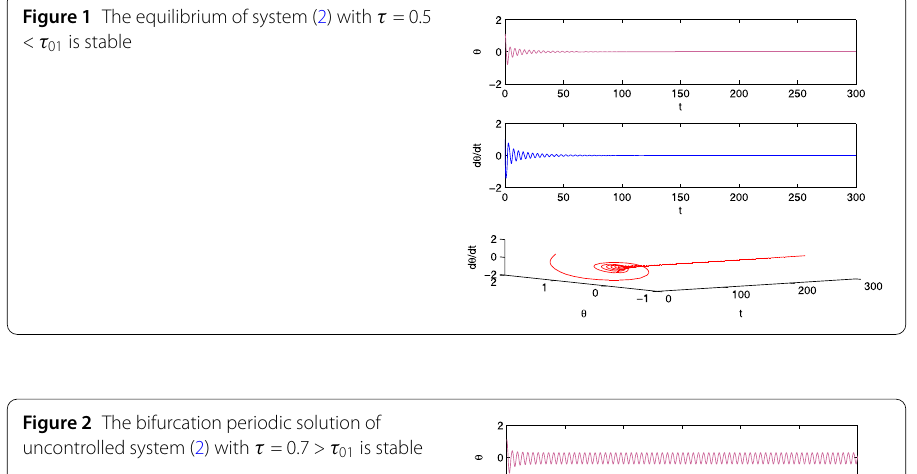
Figure 2 The bifurcation periodic solution of uncontrolled system (2) with τ = 0.7 > τ 01 is stable